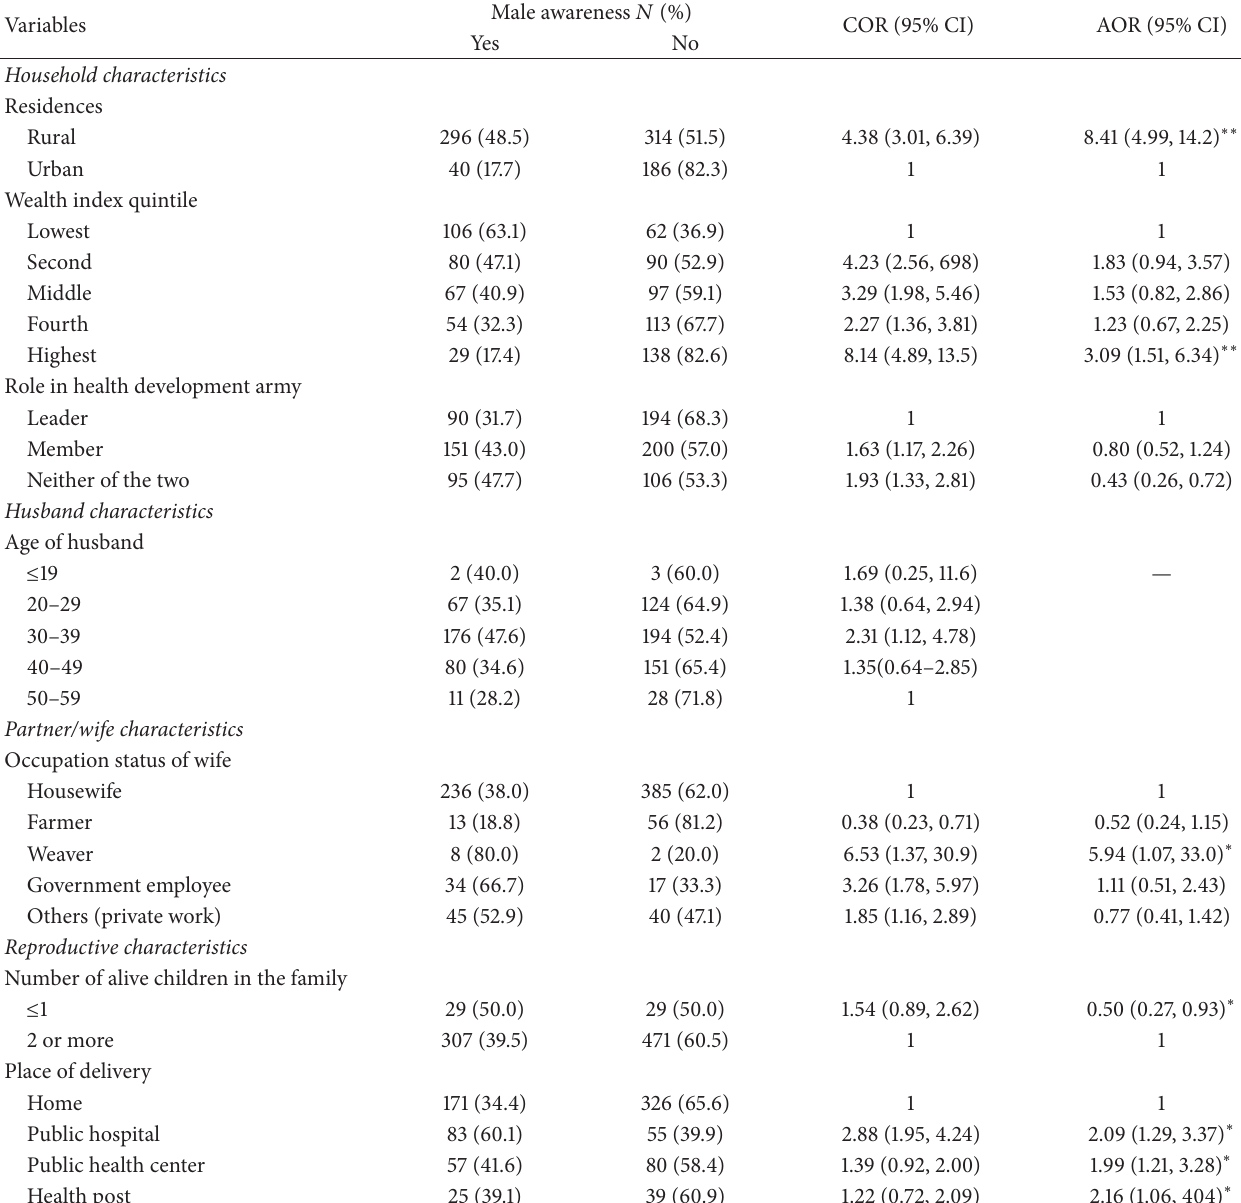
Table 2: Factors associated with men’s awareness of danger signs of obstetric complications at Chencha district of southern Ethiopia, 2014.